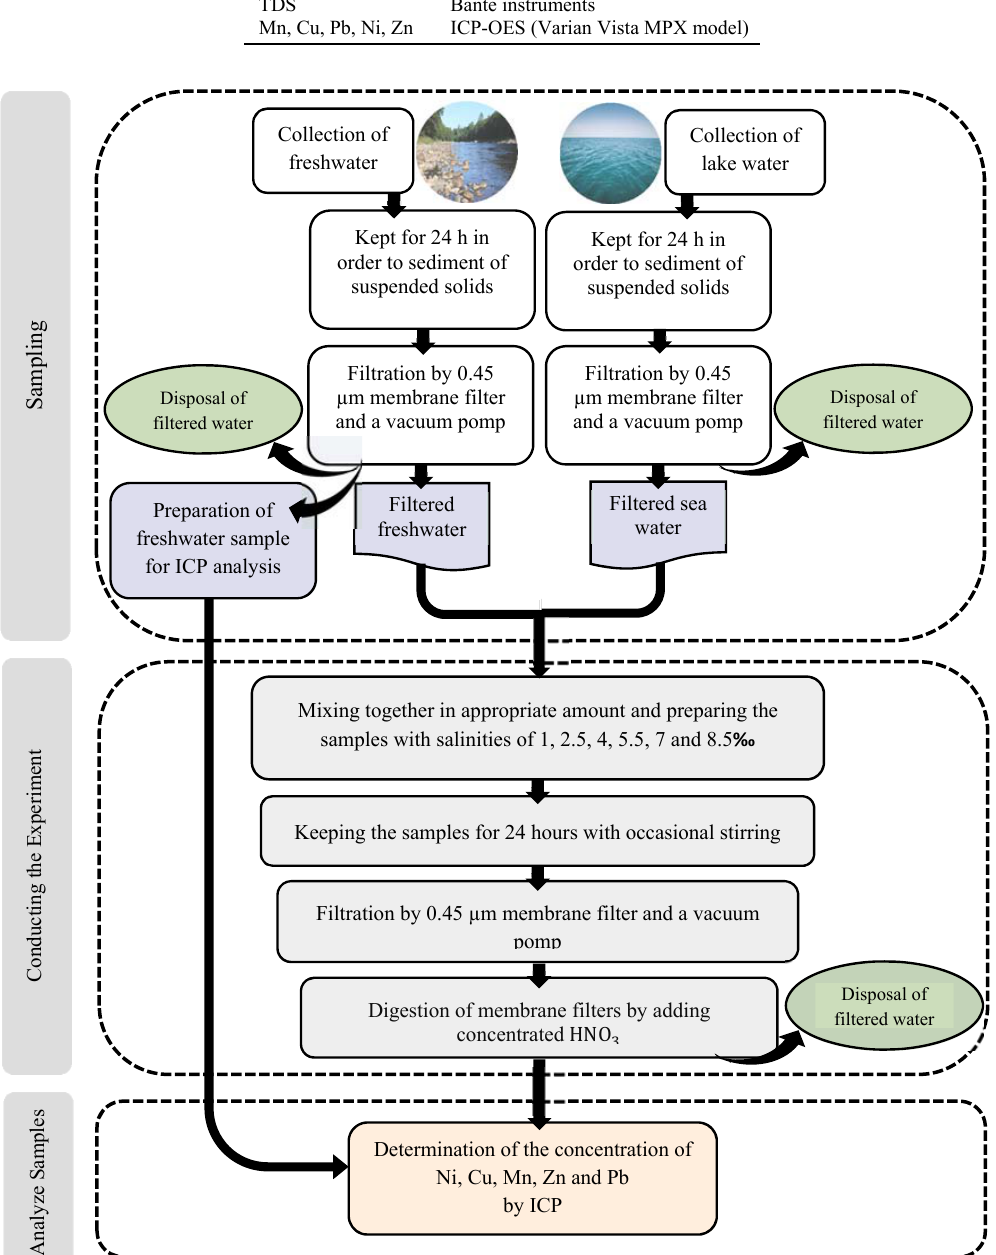
Fig. 3: A flow chart describing the experimental methodology